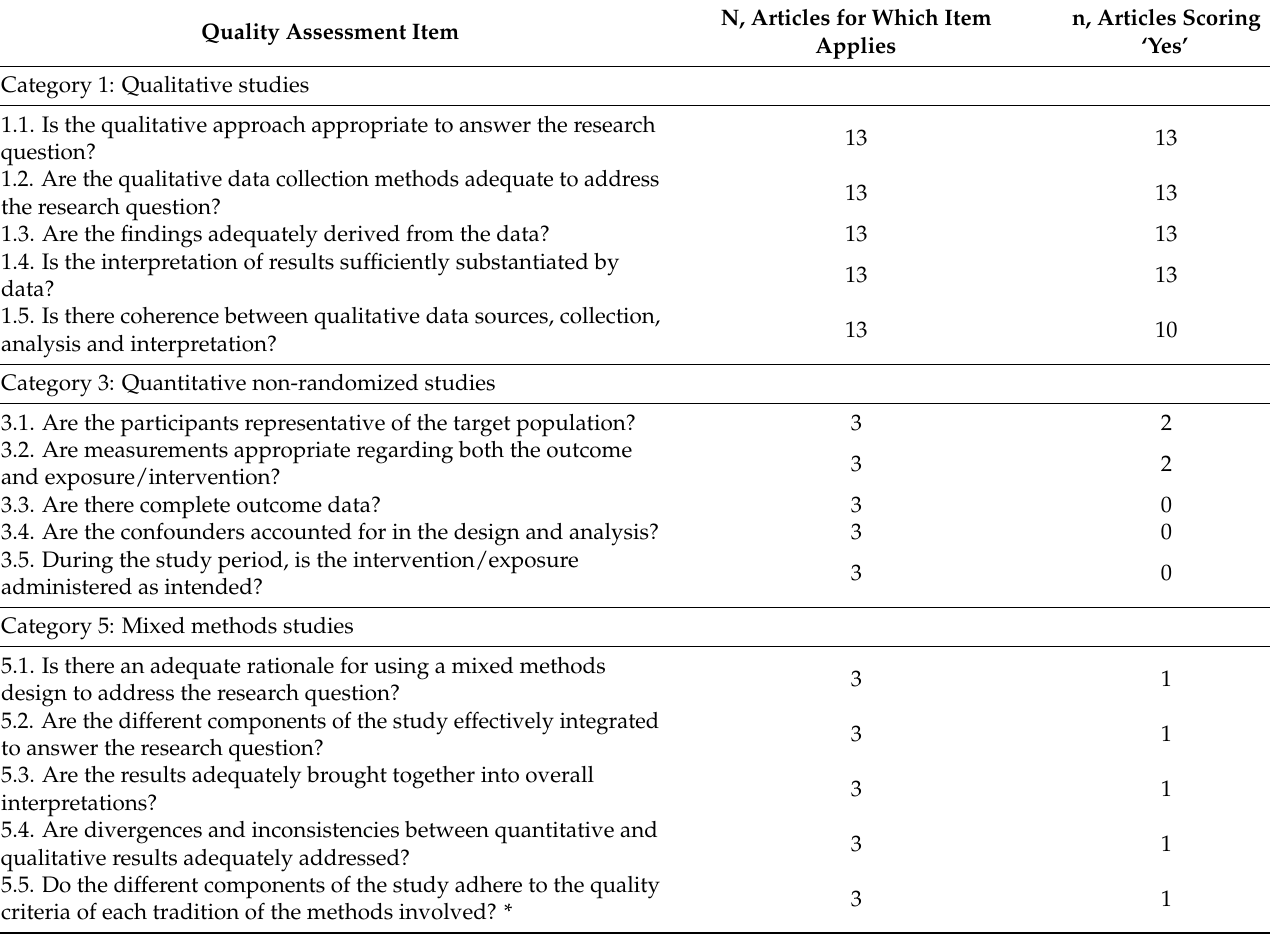
Table 3. Summary of article quality